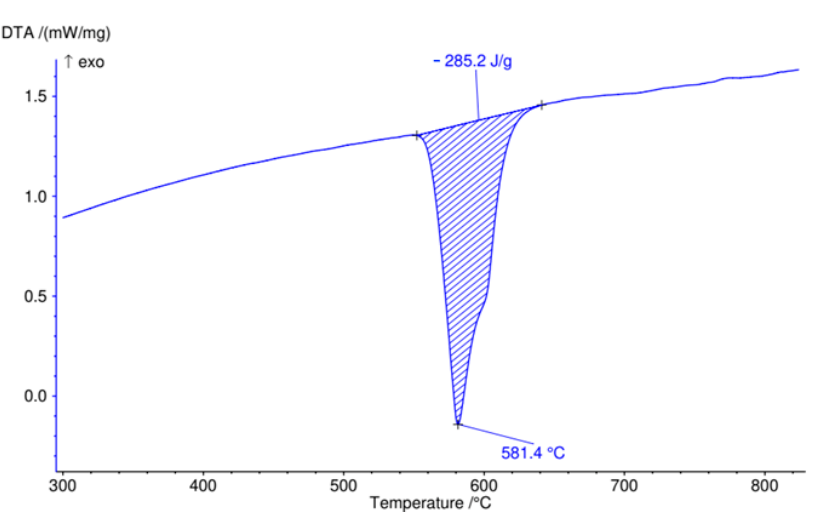
Figure 9. Differential thermal analysis (DTA) heating curve up to 800 °C for the composite aluminum alloy—SiC particles.